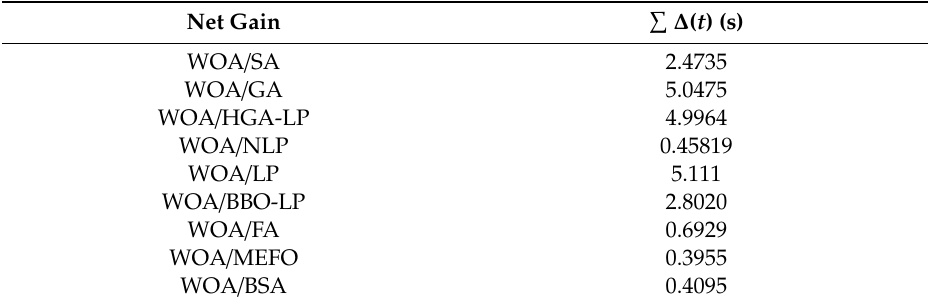
Table 8. Comparison of total net gain in time achieved by WOA with the methods used in the literature for the IEEE eight-bus